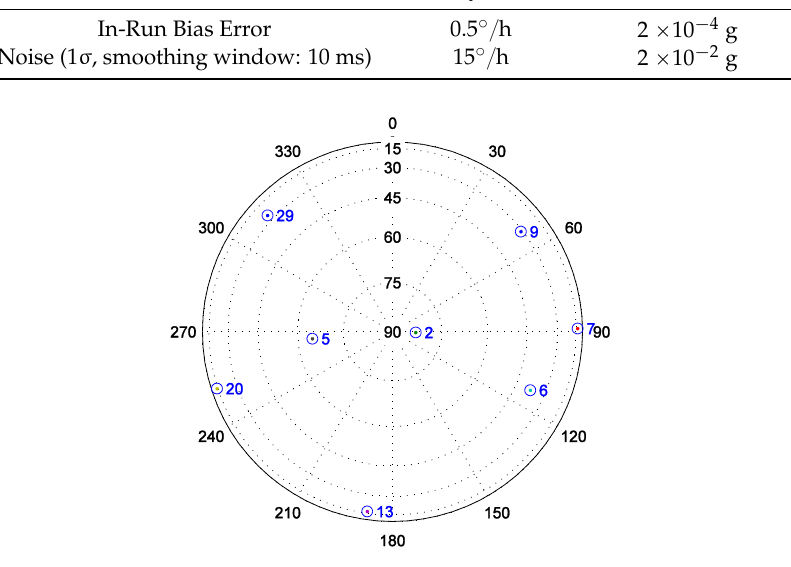
Figure 11. Satellites sky plot of the simulation.